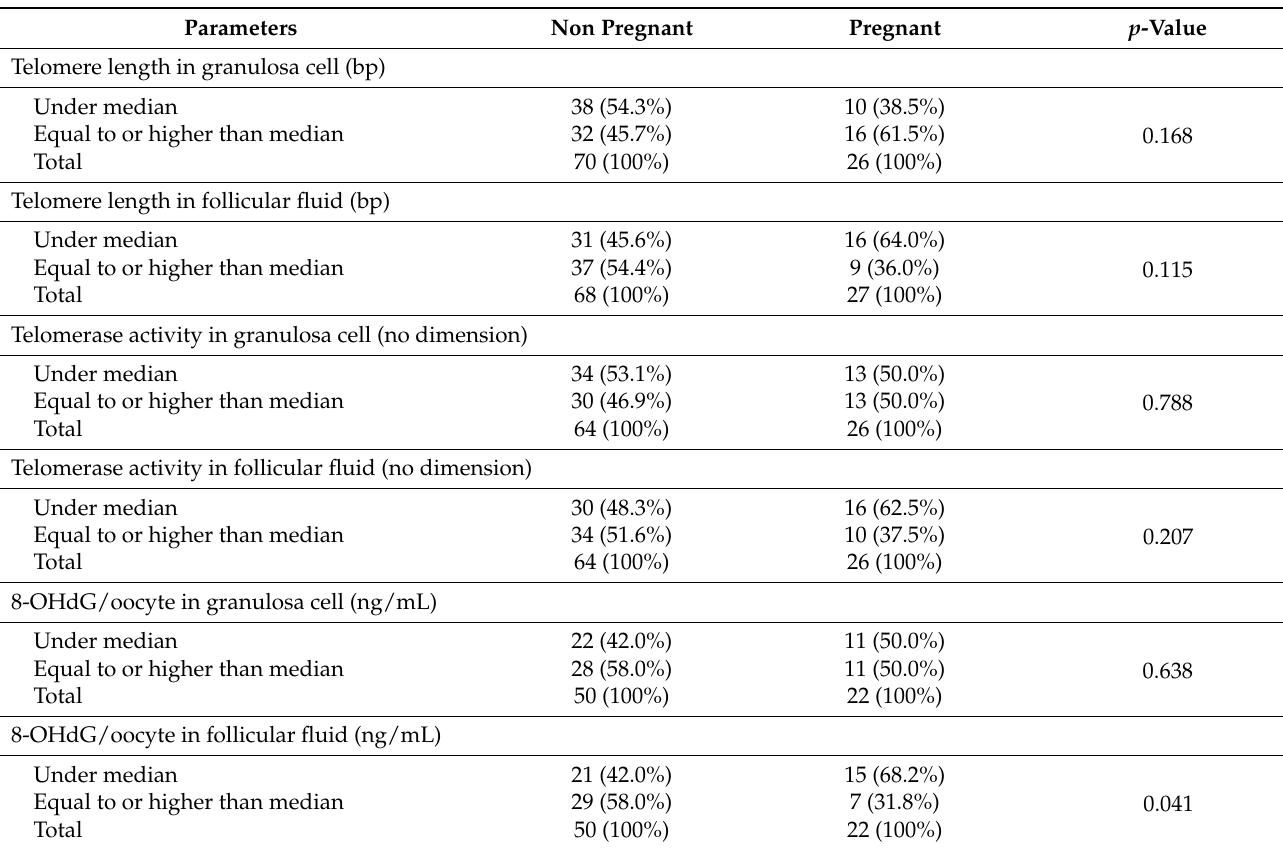
Table 9. Patients’ distribution according to the median values of the telomere length, telomerase activity and 8-OHdG